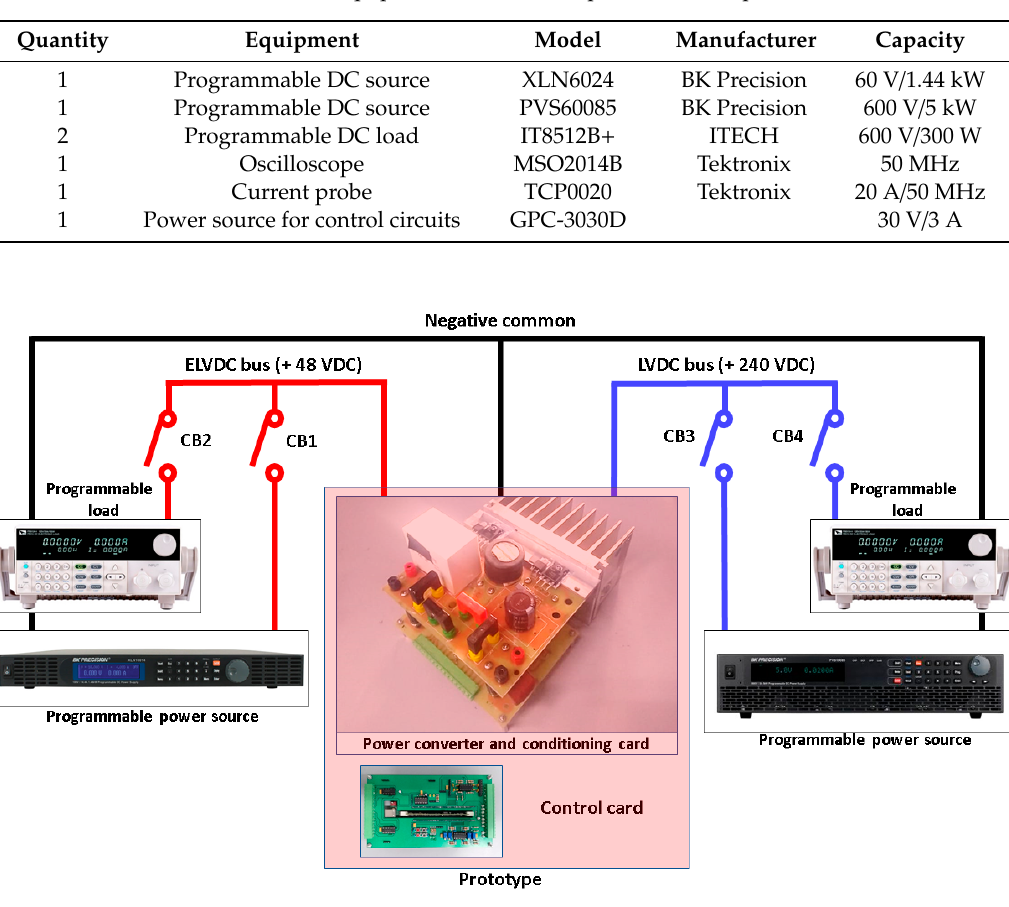
Figure 16. Schematic electrical diagram of the configured laboratory experiment.